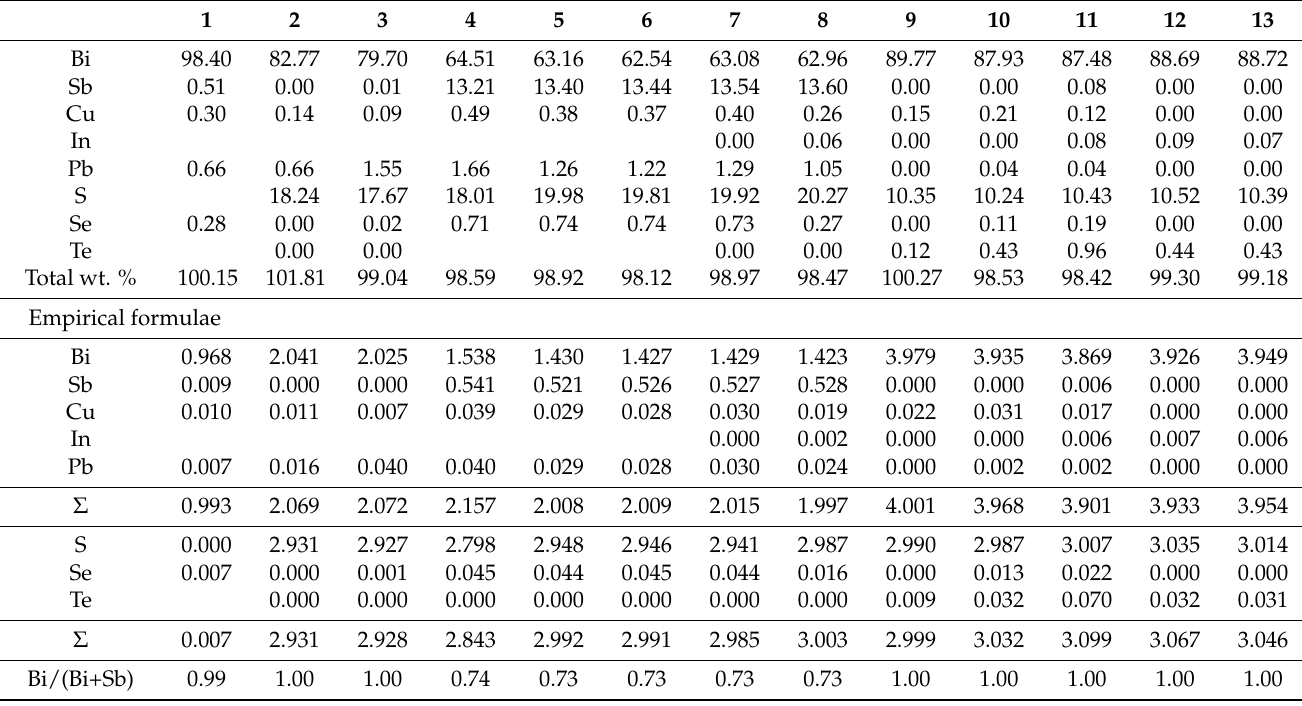
Table 9. Chemical composition of bismuth (an. 1), bismuthinite (an. 2–8; A-type: an. 2–3, B-type: an. 4–8) and ikunolite (an. 9–13) from ˇCuˇcma (Majersk á